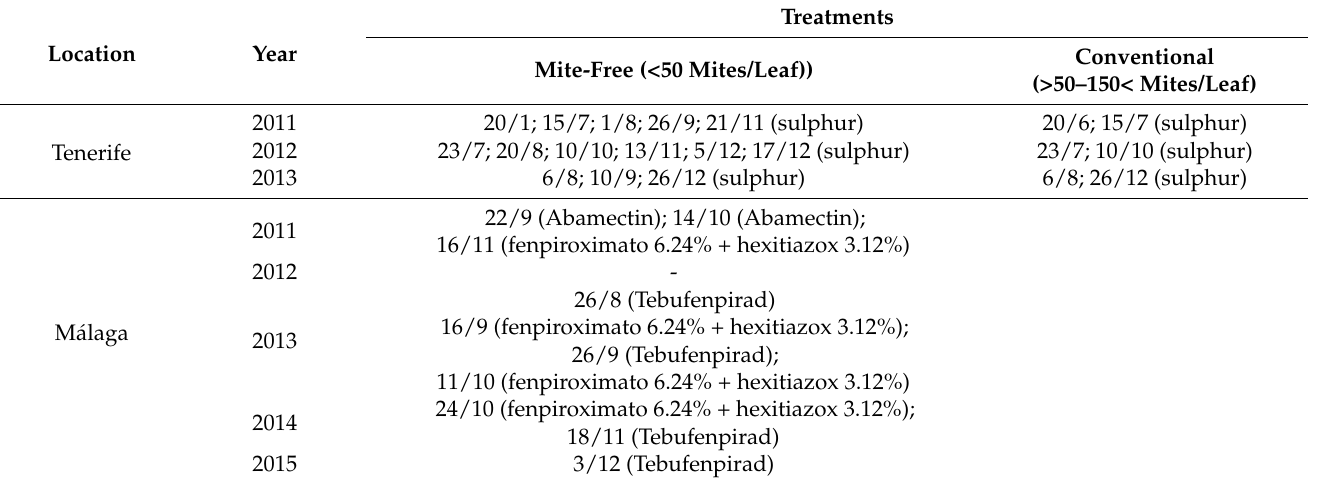
Table 1. Spray dates for two treatments (mite-free and conventional), over 3 years (Tenerife) and 5 years (M á